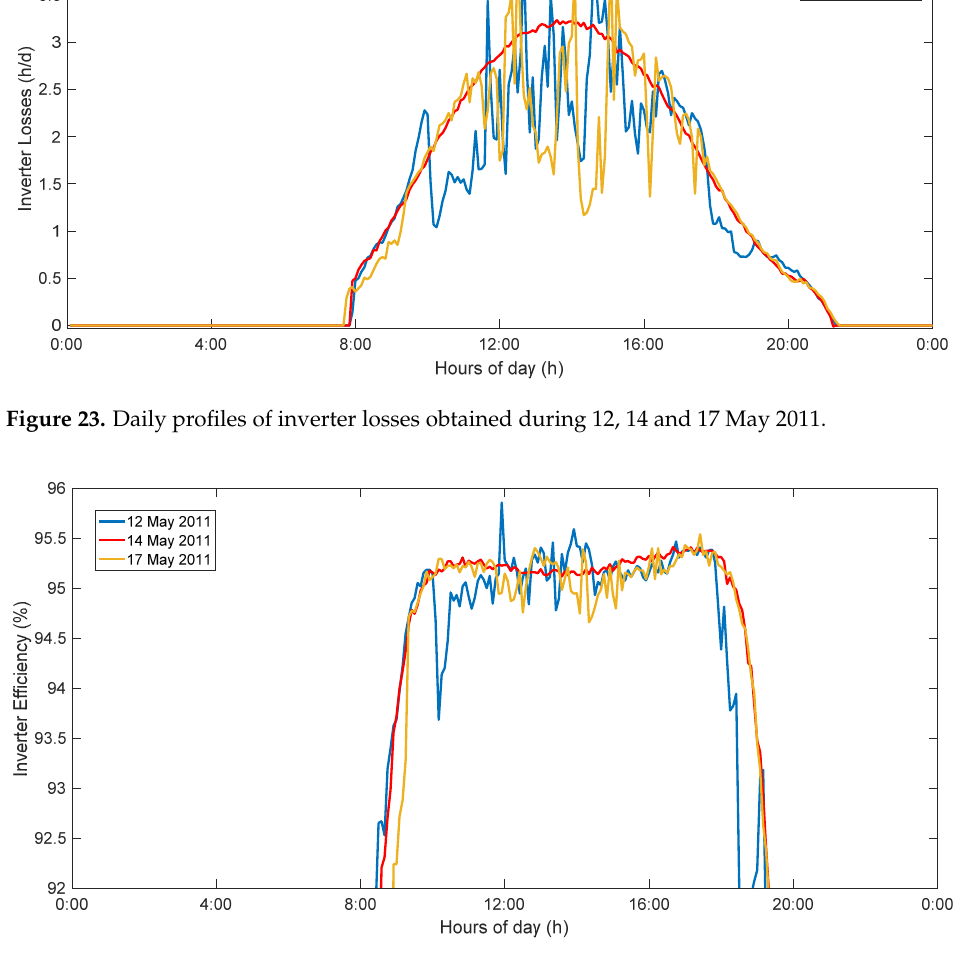
Figure 24. Daily profiles of inverter efficiency obtained during 12, 14 and 17 May 2011.